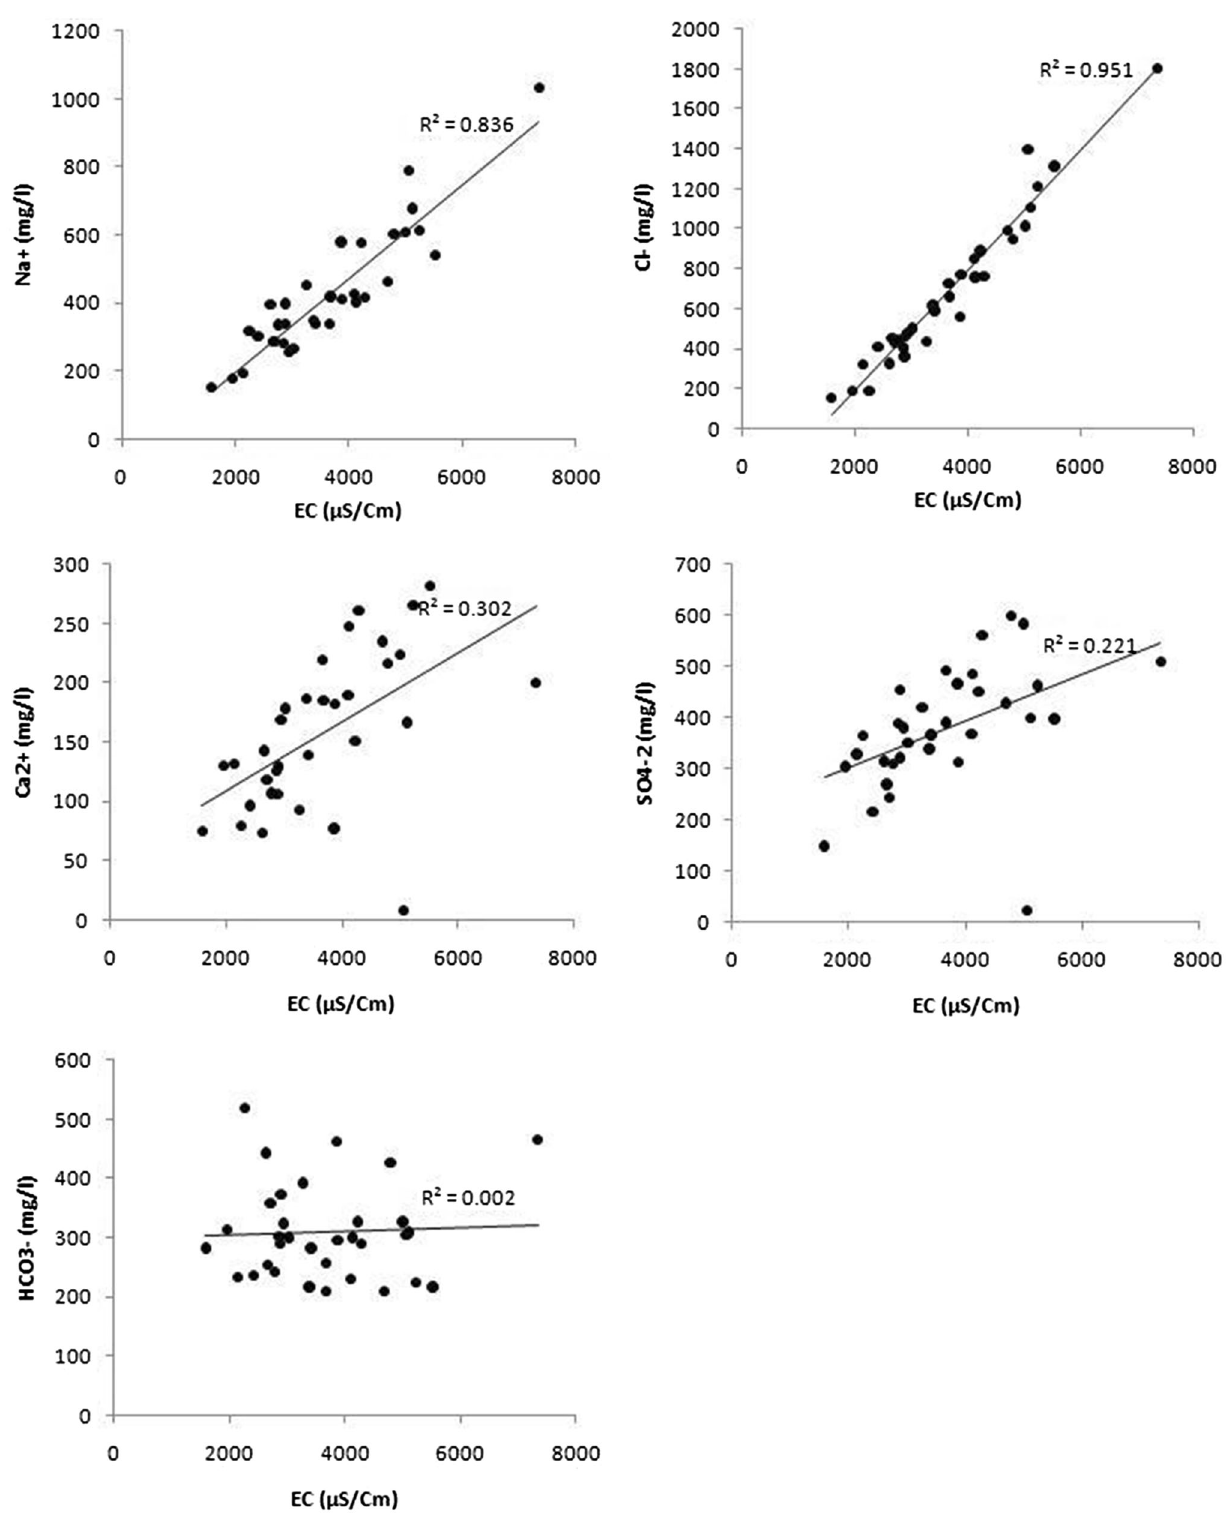
Fig. 7 Major ion concentration ( vertical axis ) versus EC ( horizontal axis ). The linear correlation between them is shown by R